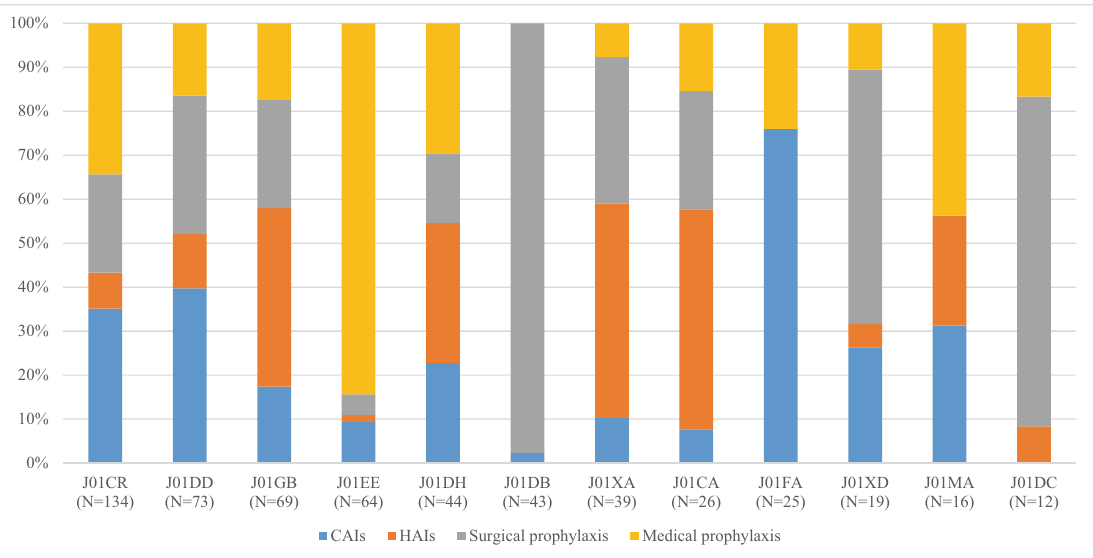
Figure 1. Proportions of treatment by antibiotic drugs and indication of use. Only antibiotic drugs with a frequency of treatment > 1.0% are showed. J01CR: Combinations of penicillins, incl. beta-lactamase inhibitors; J01DD: third generation cephalosporins; J01GB: Other aminoglycosides; J01EE: Combinations of sulfonamides and trimethoprim; J01DH: Carbapenems; incl. derivatives; J01DB: First-generation cephalosporins; J01XA: Glycopeptide antibacterials; J01CA: Penicillins with extended spectrum; J01FA: Macrolides; J01XD: Imidazole derivatives; J01MA: Fluoroquinolones; J01DC: Second-generation year of life, in males with respect to females, in patients without comorbidities compared to those who had at least one chronic disease, and in patients who underwent at least one surgical procedure (Table 1). Prophylaxis was the main indication for antibiotic use (217/380; 57.1%). Children receiving antibiotics for surgical or medical prophylaxis accounted for 14.3% (116/810) and 12.7% (103/810) of the hospitalized patients, respectively. Surgical prophylaxis lasted more than 24 h in 76.7% of the patients (89/116). Patients treated for CAIs were 13.2% (107/810) of children, followed by patients treated for HAIs (61/810; 7.5%). Overall, 587 drugs were issued to the 380 patients receiving antibiotics (1.5 antibiotic per patient), mainly administered intravenously (465/587; 79.2%). Prescriptions for treatments were 42.8% (251/587); of those, the (137/251). In 23.1% of the prescriptions (58/251), the results of the antibiogram were available and the antibiotic therapy could be considered as targeted, whereas 68.1% (171/251) of the treatments were empirical. The main infection sites were respiratory tract infections (both low tract and pneumonia), bloodstream infections, and urinary tract infections, which were reported as the reason for therapy in respectively 29.9%, 23.5% and 2.4% of the antibiotic treatments for infections. The top three antibiotic classes were combinations of penicillins including β-lactamase inhibitors (J01CR; 134/587, 22.8%), third-generation cephalosporins (J01DD; 73/587, 12.4%) and aminoglycosides (J01GB; 69/587, 11.8%, Fig. 1). The pattern of antibiotic use varied by indication: about 98.0% (42/43) of first-generation cephalosporin pre- scriptions (J01DB) were issued for surgical prophylaxis, followed by second-generation cephalosporins (J01DC; 9/12, 75.0%) and imidazole derivatives (J01XD; 11/19, 57.9%) (Fig. 1). Combinations of sulphonamides and trimethoprim (J01EE), fluoroquinolones (J01MA) and combinations